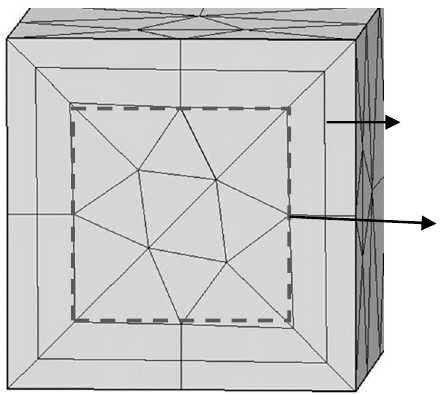
Figure 2. Tetrahedral structures in the core of the channel involved in a shell.